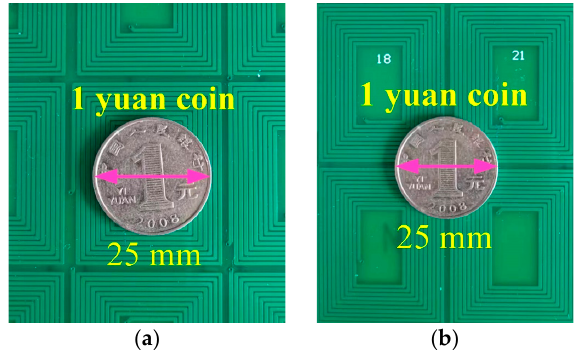
Figure 9. Metal foreign object in the center and the corner position relative to the detection coil. ( a ) center position; ( b ) corner position.